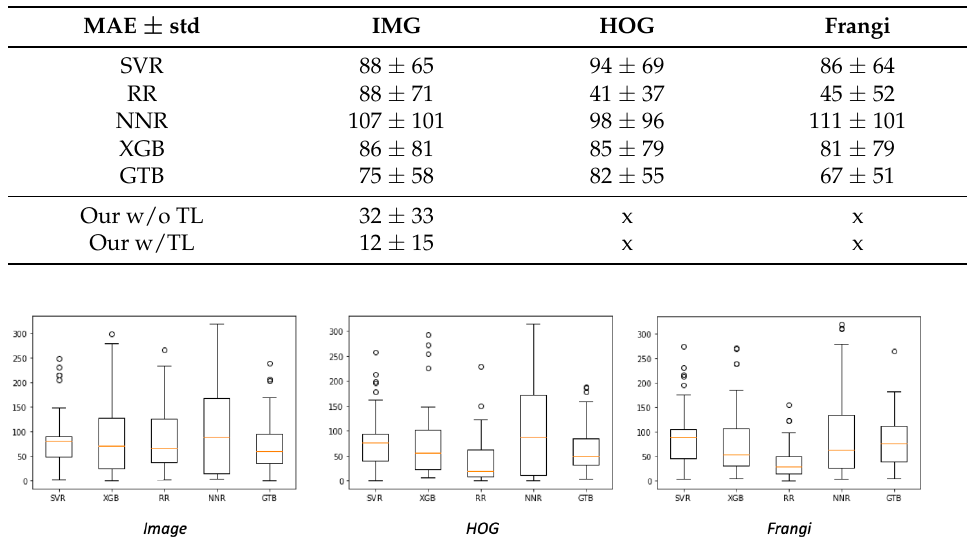
Table 1. Results of applying various feature extraction methods in combination with different regressors vs. our approach.